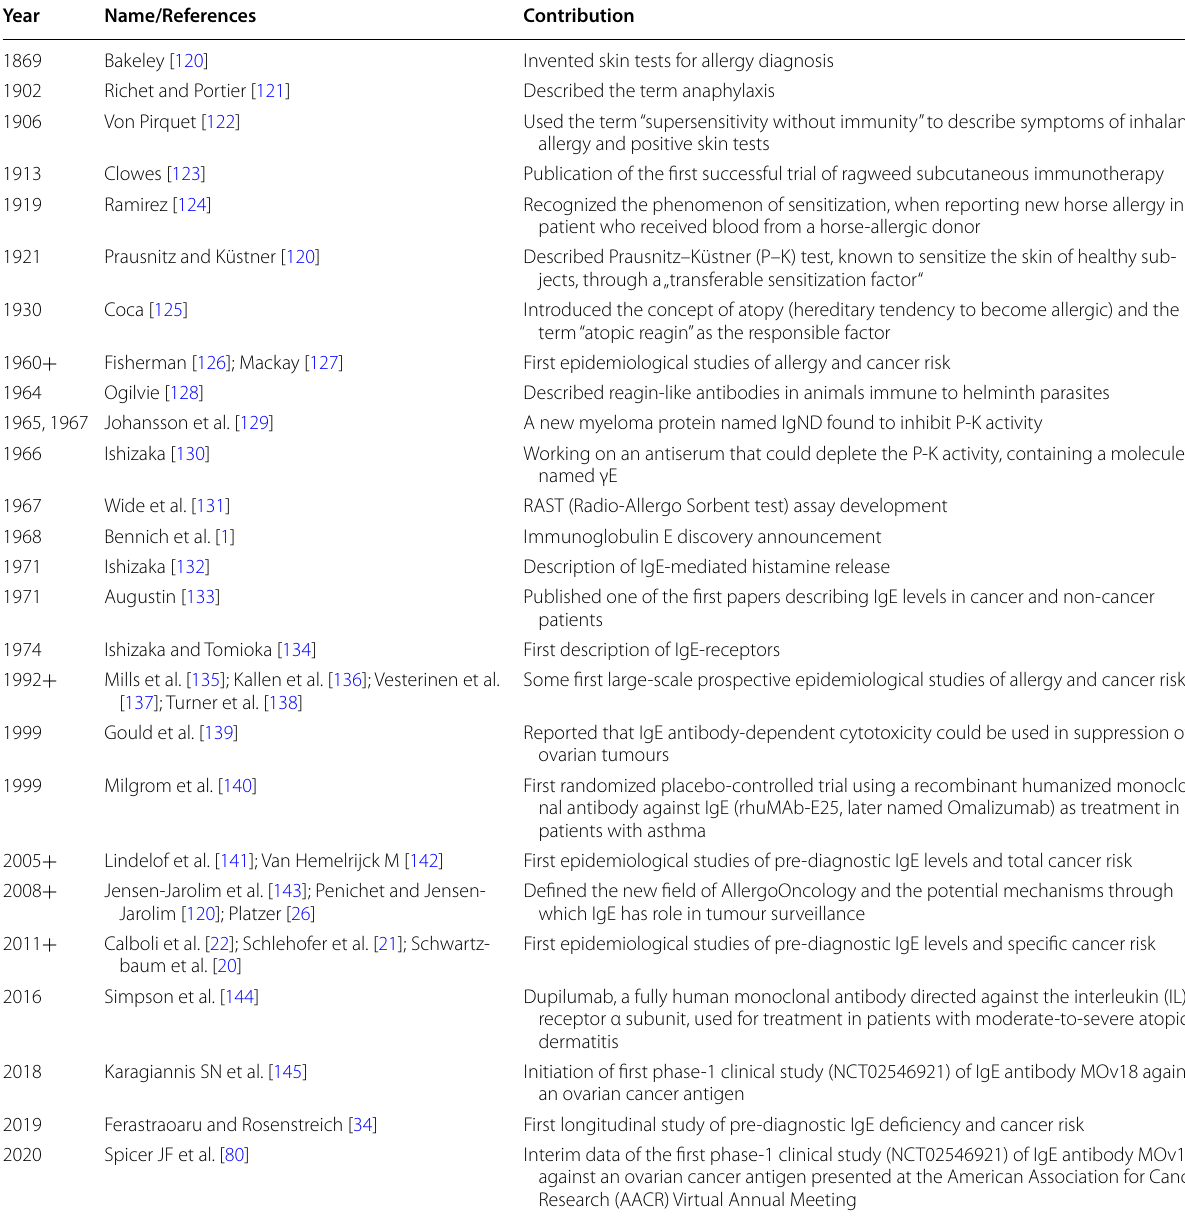
Table 1 Significant historical events related to